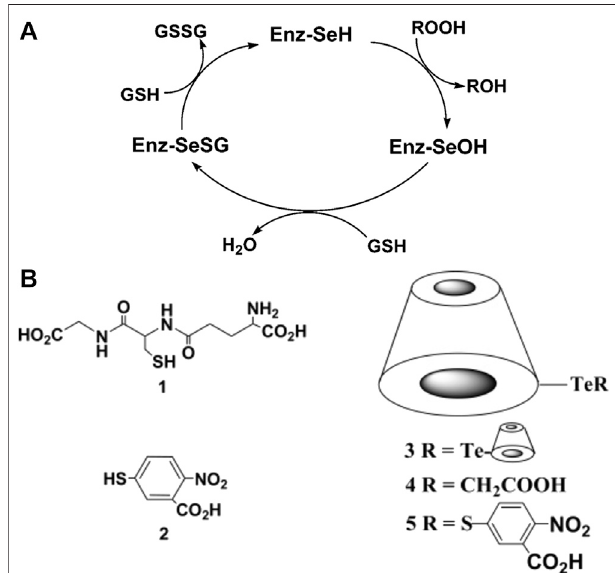
FIGURE 1 | (A) The catalytic mechanism of GPx. GPxs catalyze the reduction of peroxides at the expense of glutathione molecules, involving the formation and breaking of Se-S covalent bond. (B) Chemical structures of the substrates of GPx (left) and the tellurium-containing CD (right). A and B Reproduced from Dong et al. (2004) with permission. Copyright 2004 American Chemical